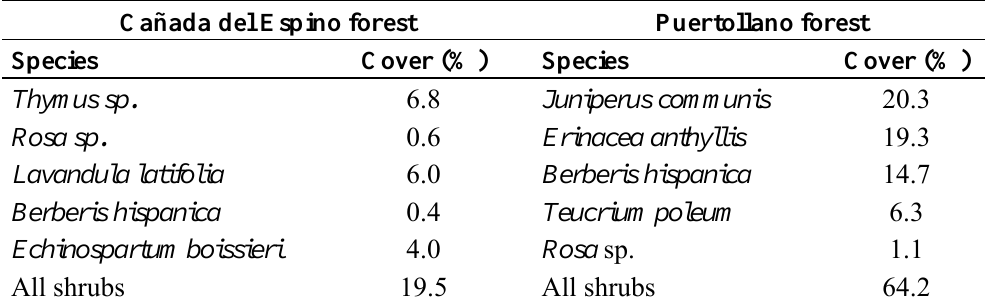
Table 1. Shrub cover in the two study